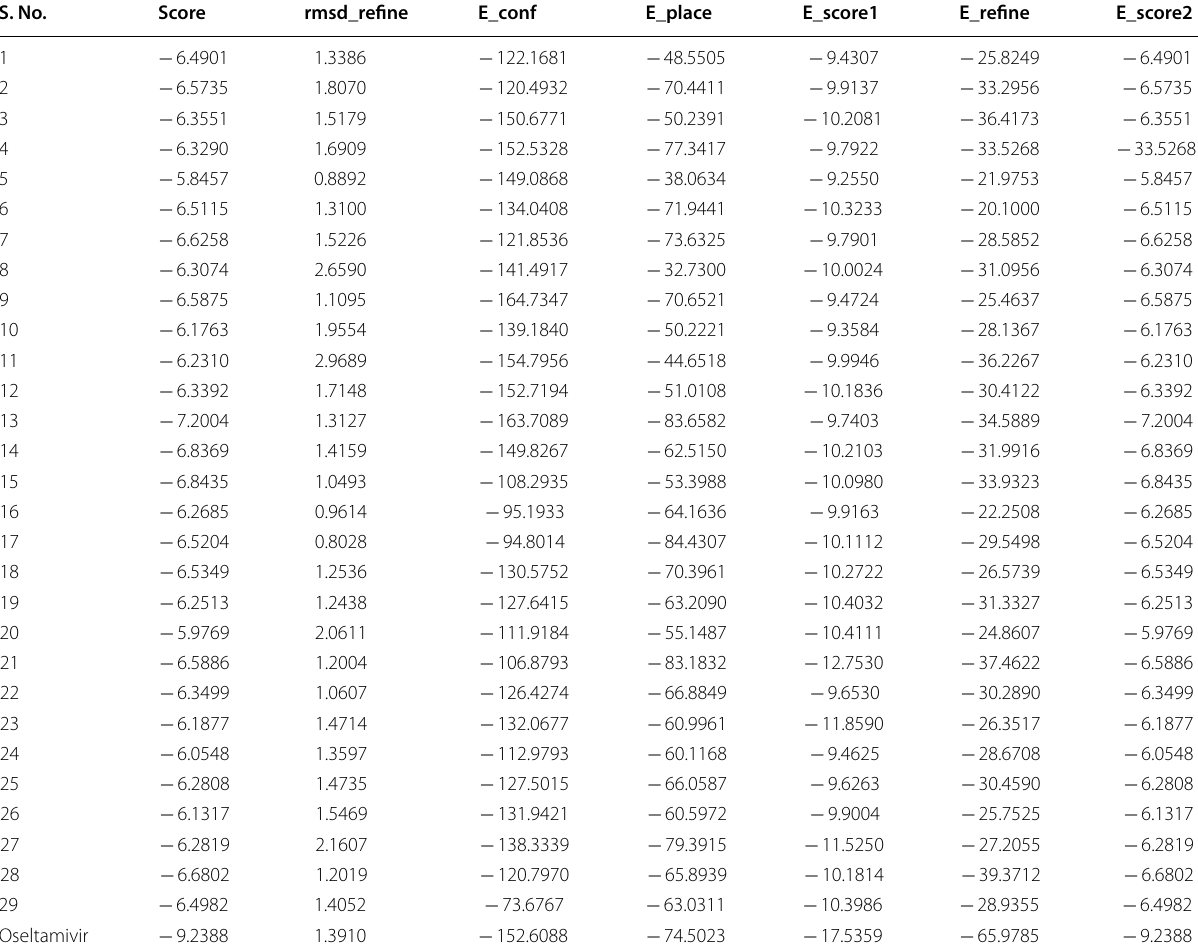
Score: the final docking score, rmsd_refine: the root-mean-square deviation between the pose before and after refinement, E_conf: the energy of the conformer. E_refine: core from the refinement stage, calculated to be the sum of the van der Waals electrostatics and solvation energies, under the generalized Born solvation model (GB/VI), E_score1: score from rescoring stages 1, E_place: score from the placement stage, E_score2: score from rescoring stages 2